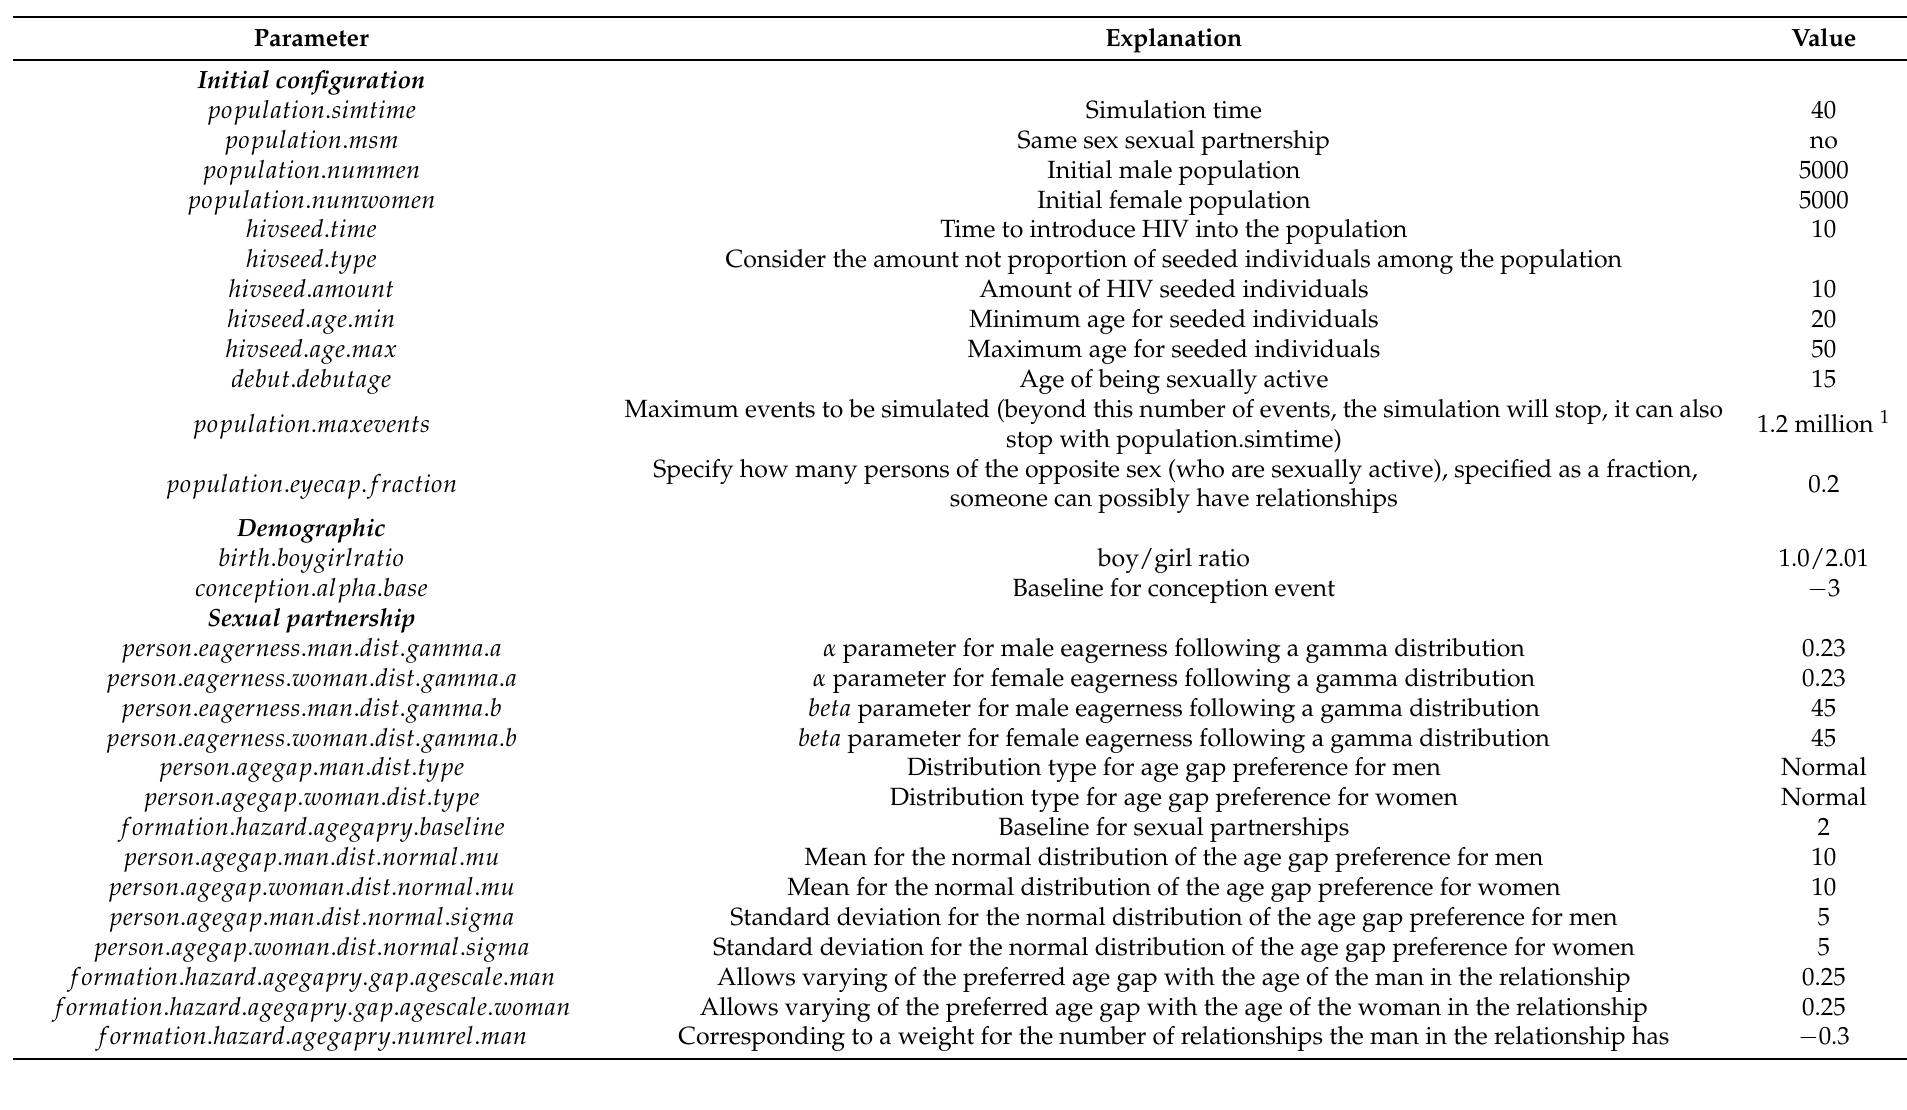
Table A1. Values of selected parameters for the simulation of HIV